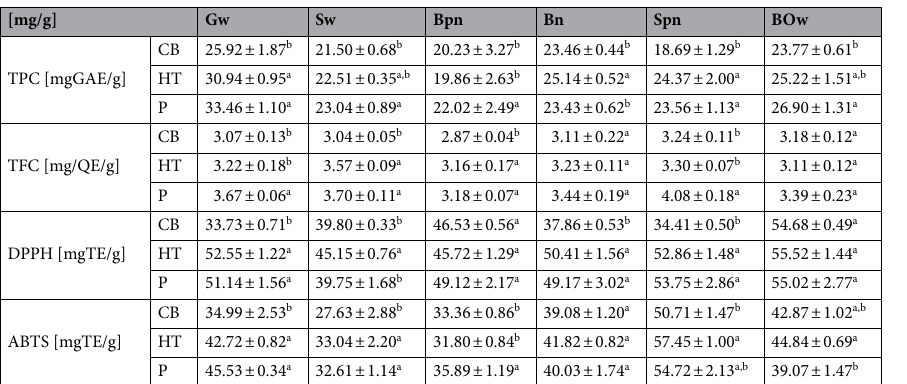
Table 3. Comparison of coffee infusions prepared in different brewing processes of the effects on their bioactive and antioxidant properties. Mean value ± standard deviation, n = 6.The superscripts a, b, c denote significant (p < 0.05) differences between Hardtank, traditional cold and hot brewing method within the same coffee sample CB cold brew, HT Hardtank, P Hot brew coffee, Gw Guatemala washed, Sw El Salvador washed, Bpn Brazil pulped natural, Bn Brazil natural, Spn El Salvador pulped natural, Bow Bolivia washed.